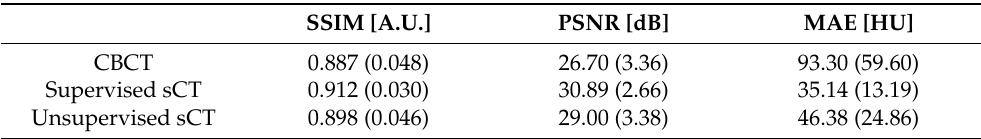
Figure 5. Quantitative analysis of SSIM, PSNR, and SSIM values between original CBCT, sCT supervised, and sCT unsupervised against the corresponding CT, computed for each fold of the four-fold cross-validation. Table 1. Performance metrics evaluated on original CBCT, sCT supervised, and sCT unsupervised. Every value is computed against the original CT, considered as the ground truth. Every value is expressed as median (interquartile